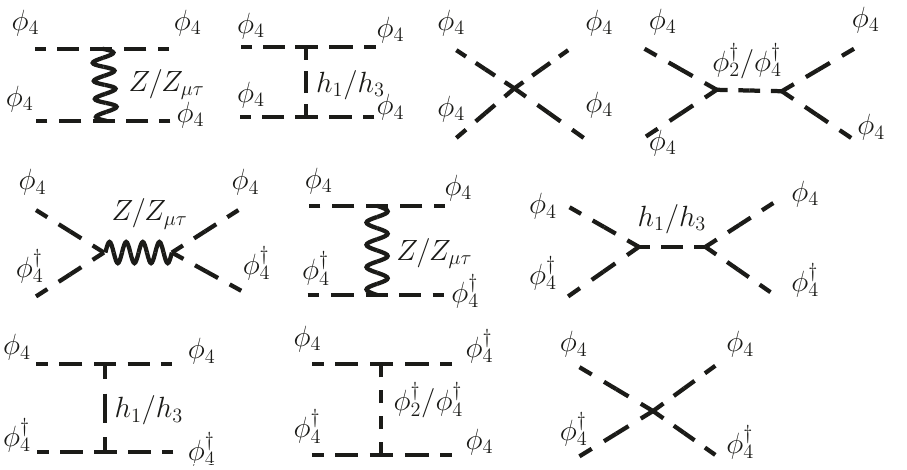
. The diagrams for 4